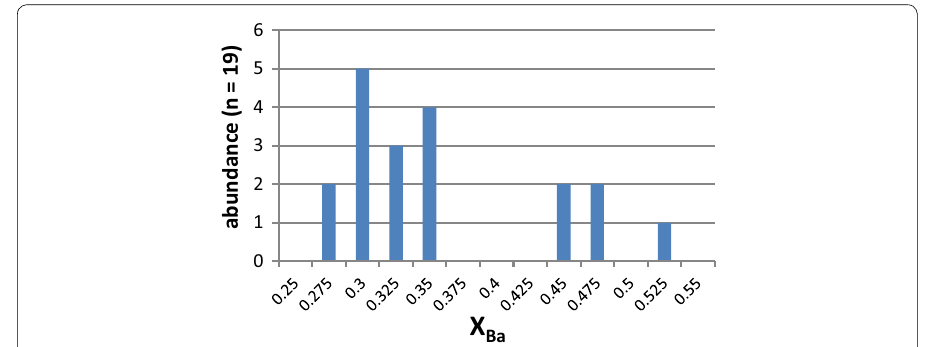
Fig. 3 Histogram of Ba mole fractions measured by SEM–EDX point analyses throughout (Ba,Sr)SO 4 on the cut and polished sample